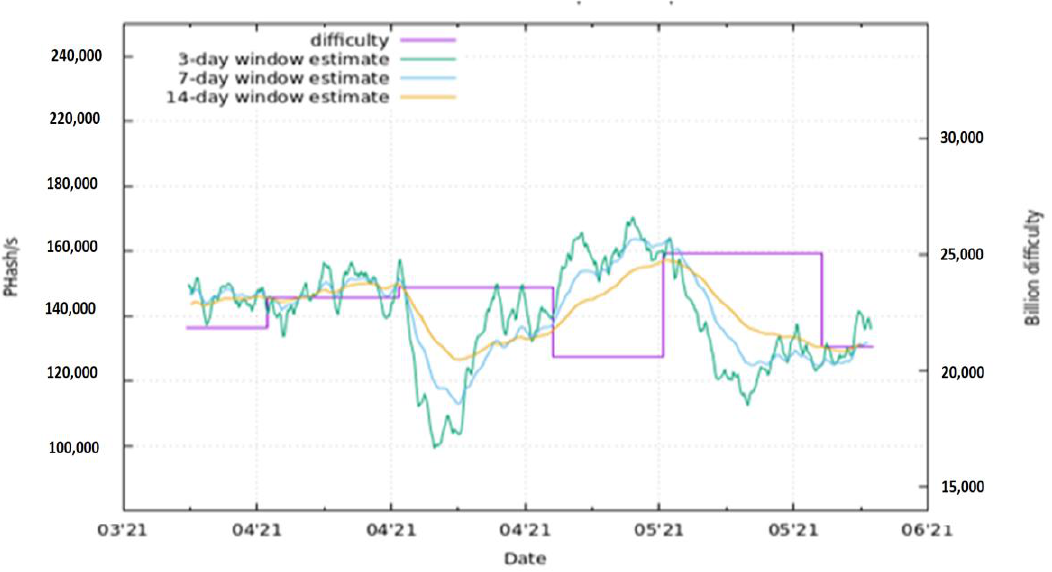
Figure 8. Difficulty with respect to Date and PHash/s [25].